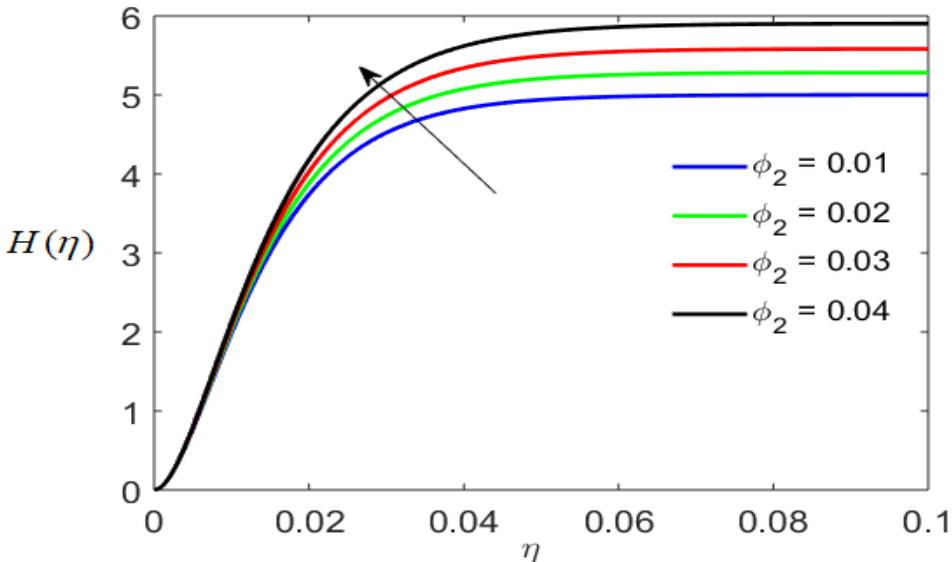
Figure 6. Axial velocity profile for varying volume fractions of nanoparticles of Al 2 O 3 .